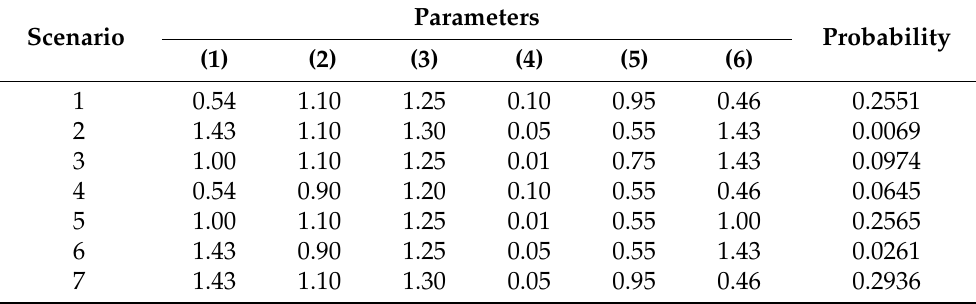
Table 10. Selected